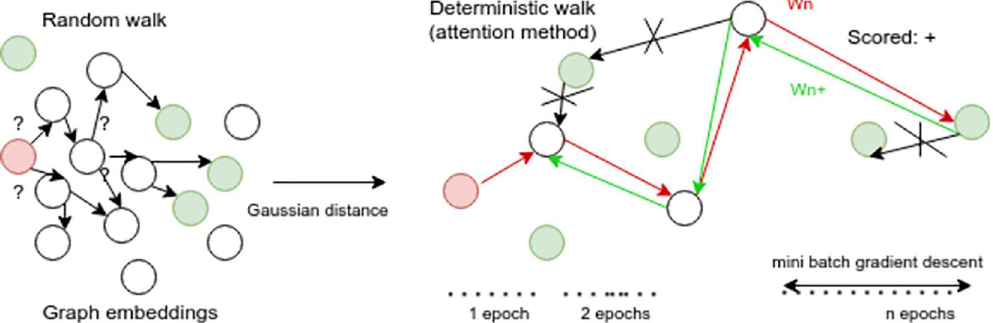
Fig 30. Neural path’s embedding +